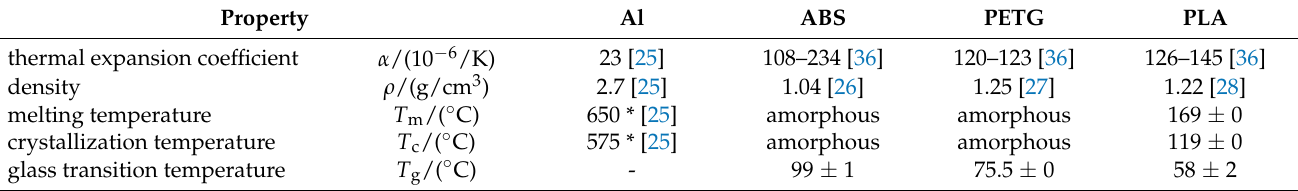
Table 2. Overview of selected thermal and mechanical properties of the materials used. The melting, crystallization and glass transition temperatures (onset) of the polymers were measured with a DSC3 (Mettler-Toledo, Columbus, OH, USA) at cooling and heating rates of 10 K/min. The thermal expansion coefficients α were not obtained for the polymers used; instead, typical ranges for ABS, PETG and PLA, respectively, are given. (*: for Al, the liquidus and solidus temperatures are given).